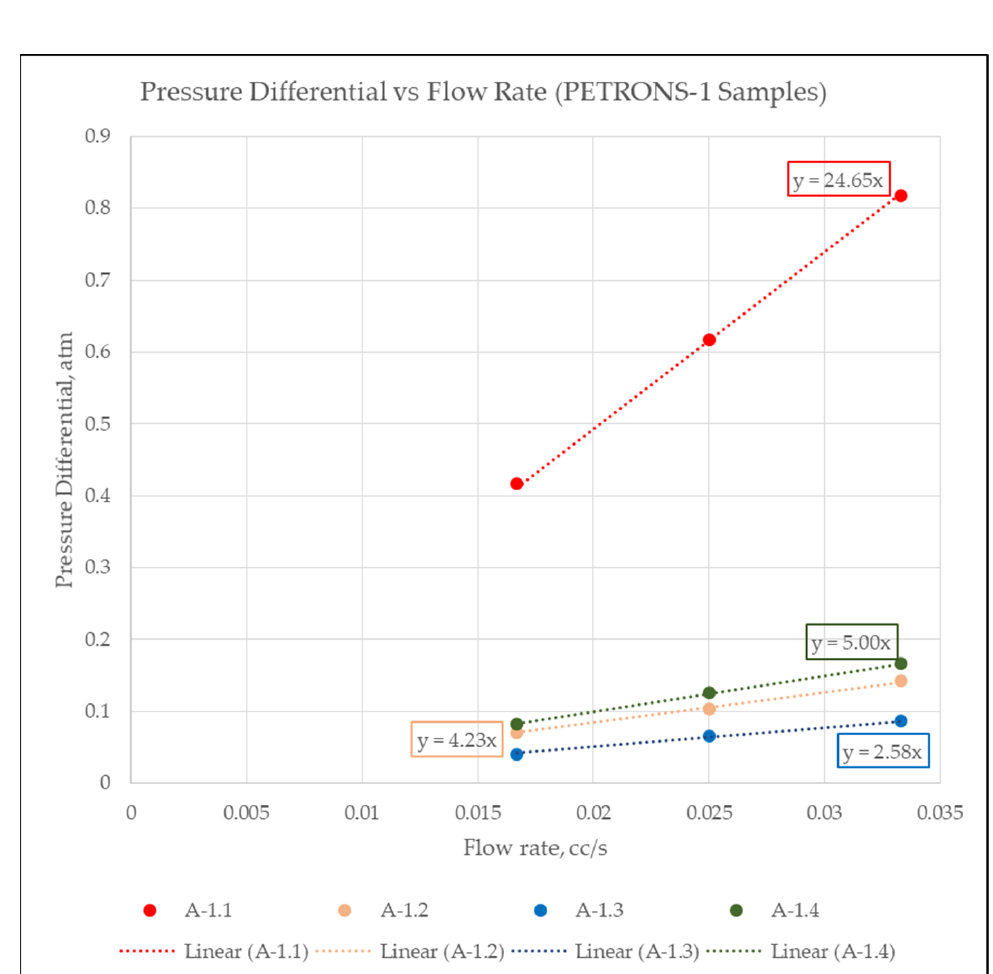
Figure 12. Graph of pressure differential against brine flow rate for PETRONS-1 samples.